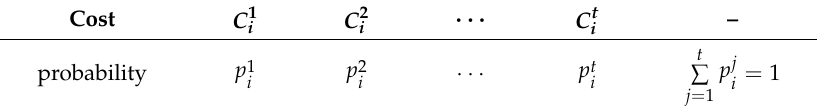
Table 2. Probability Distribution of Production Cost for the i th